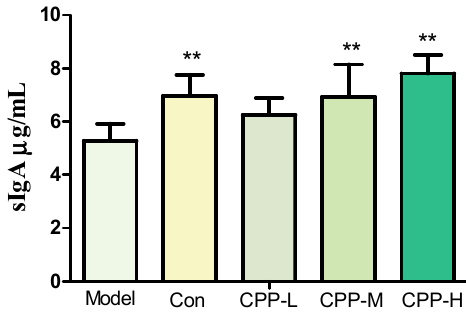
Figure 2. Effects of CPP on sIgA secretion in cyclophosphamide-treated mice. Model, model control; Con, normal control; CPP-L, 50 mg/kg bodyweight CPP treated group; CPP-M, 100 mg/kg bodyweight CPP treated group; CPP-H, 200 mg/kg bodyweight CPP treated group. The values were presented as mean ± SD. ** p < 0.01, compared with model group.